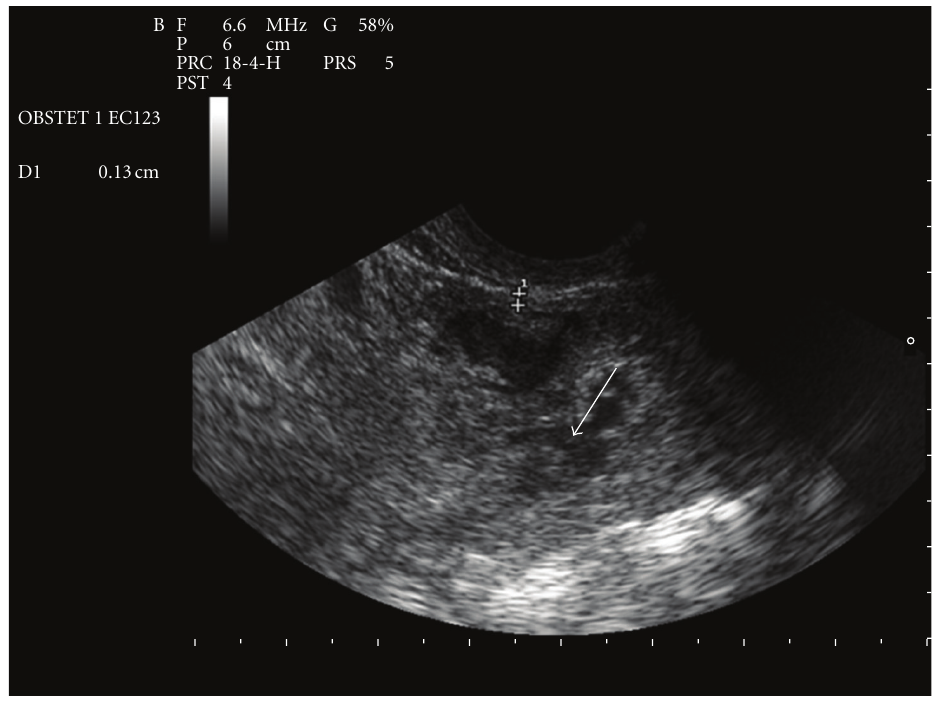
Figure 3: Transvaginal ultrasound image of the scar pregnancy only 1.3 mm of myometrium visualized in the anterior wall of the cervix, empty cervical canal (arrow).